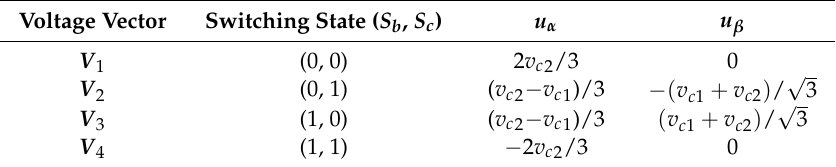
Table 1. Voltage vectors when switching device of Phase A has a fault.